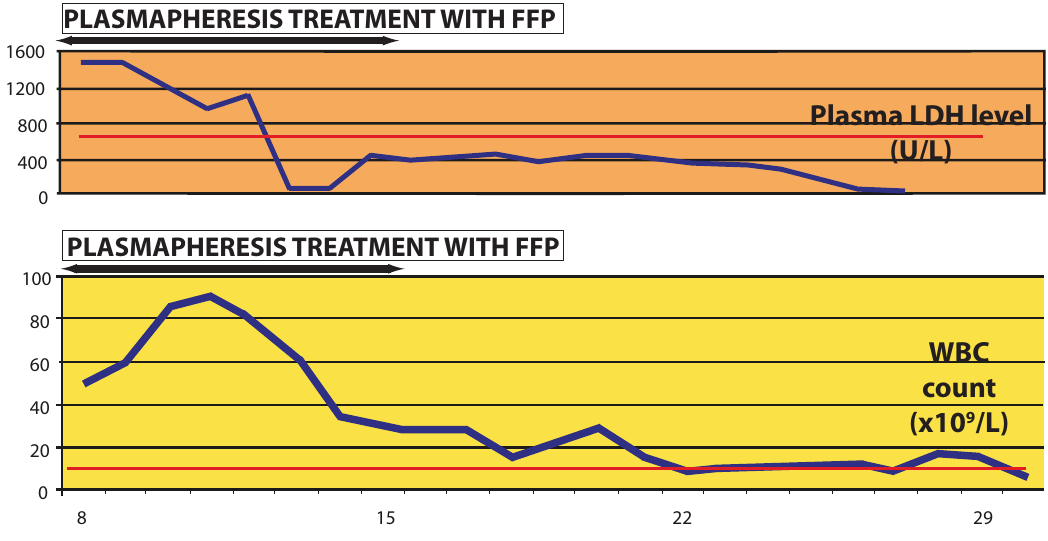
ventilation.Figure Figure 3. CT scan of thorax recorded on the 15th day of disease: massive left-sided hemothorax with atelectatic lung (arrow) that eventually required surgical treatment, as well as a careful strategy of protective invasive mechanical